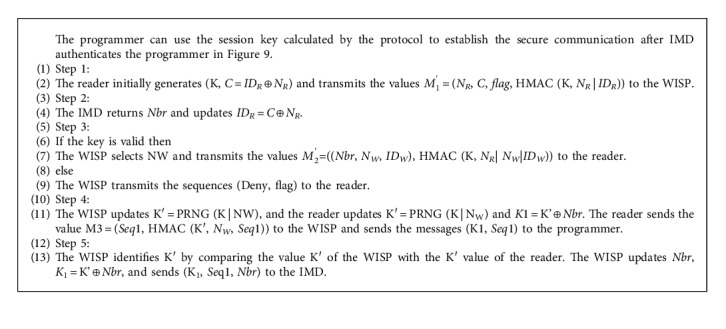
Secure communication protocol between the IMD and the programmer.